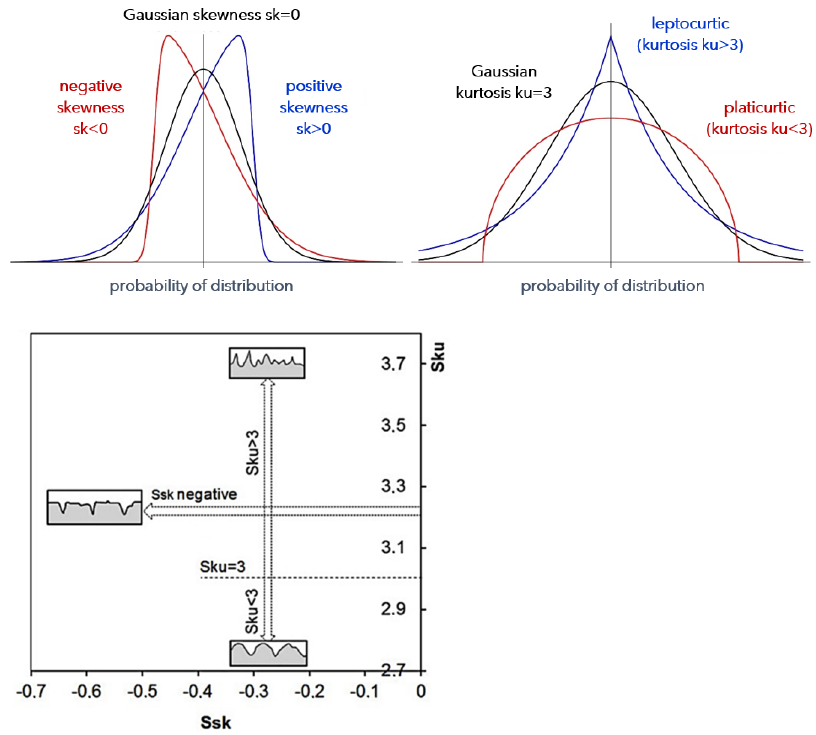
Figure 1. Skewness and kurtosis, as well as graphical interpretation related to the surface geometrical structure and its parameters Ssk and Sku [3].